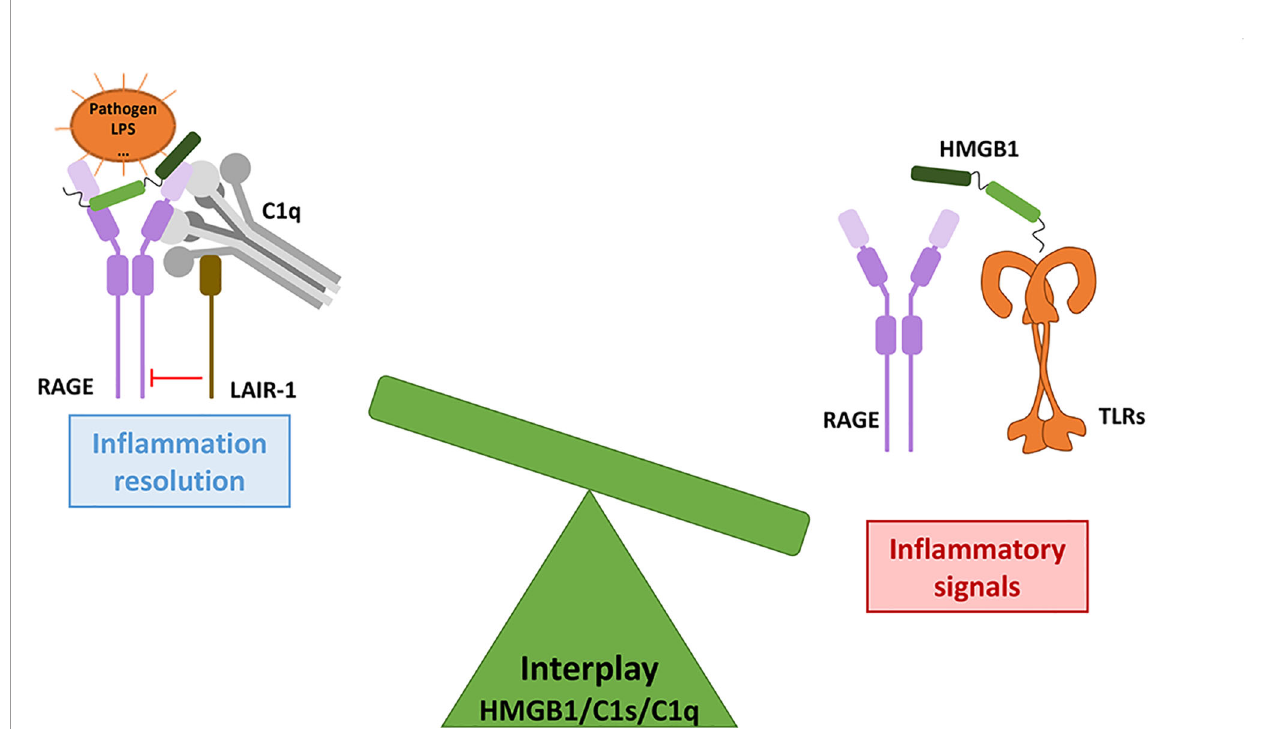
FIGURE 6 | The HMGB1/C1s/C1q interplay modulates the in fl ammatory signals from initiation to resolution. As a molecular switch, C1q can dampen the in fl ammatory signals triggered by RAGE/HMGB1, through LAIR-1 inhibitory signaling. The role of C1s in this interplay remains to be further